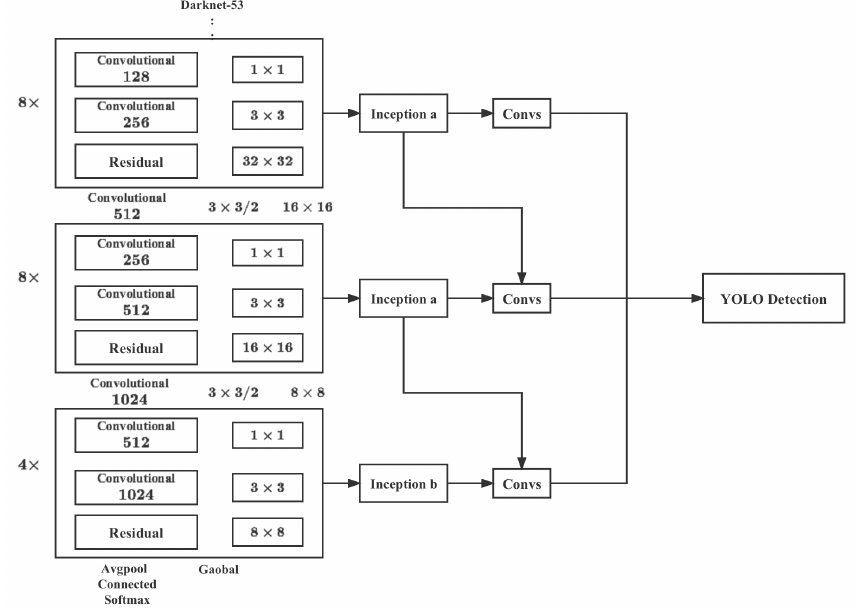
Figure 10. Structure of our inc-YOLO. This model incorporates the original Darknet and Inception structure including Inception A and Inception B in Figure